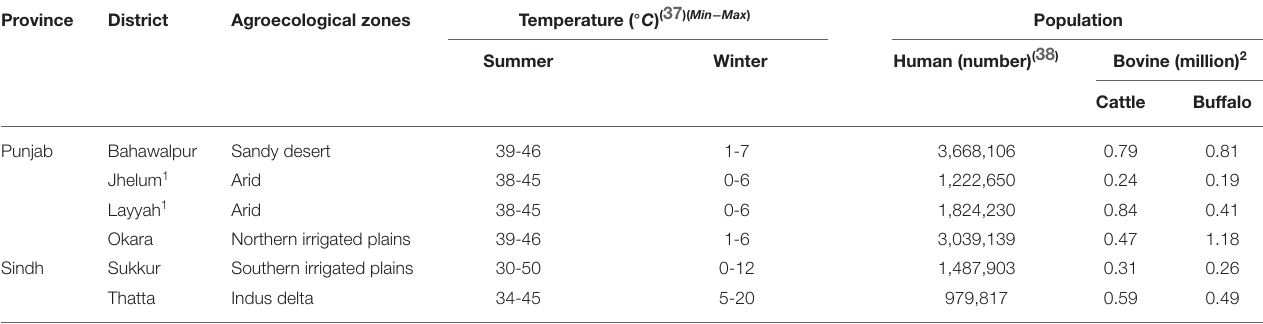
TABLE 1 | Demographic properties of districts included in the study.